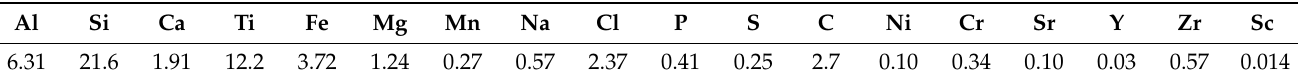
Table 3. Chemical composition of the residue of the high-pressure leaching of the IDBR sample by 10% HCl, wt. %.